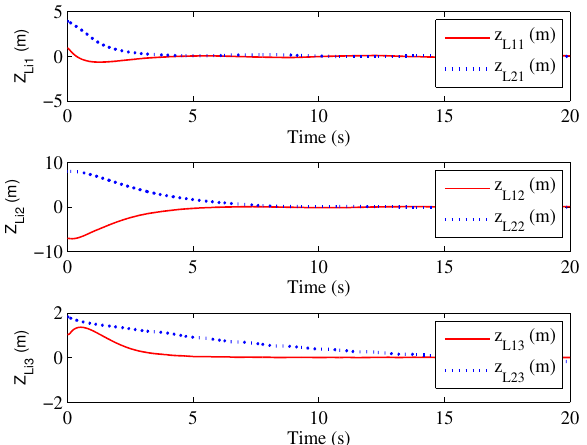
Figure 15. Generalized error of follower 1 and follower 2 with respect to the leader with the method from [39].